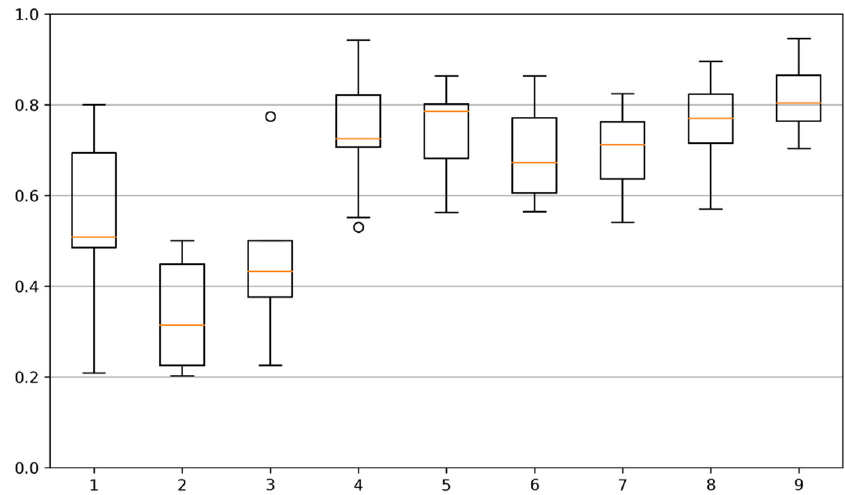
Figure 9. Jaccard similarity coefficient distribution for each testing site (1–9). The orange line represents the median value, dividing the central rectangle in the 25th percentile (below) and 75th percentile (above). The bottom and top lines represent the distribution minimum and maximum, respectively. (Outlier values are also represented as circles, above and/or below the extreme limits.).